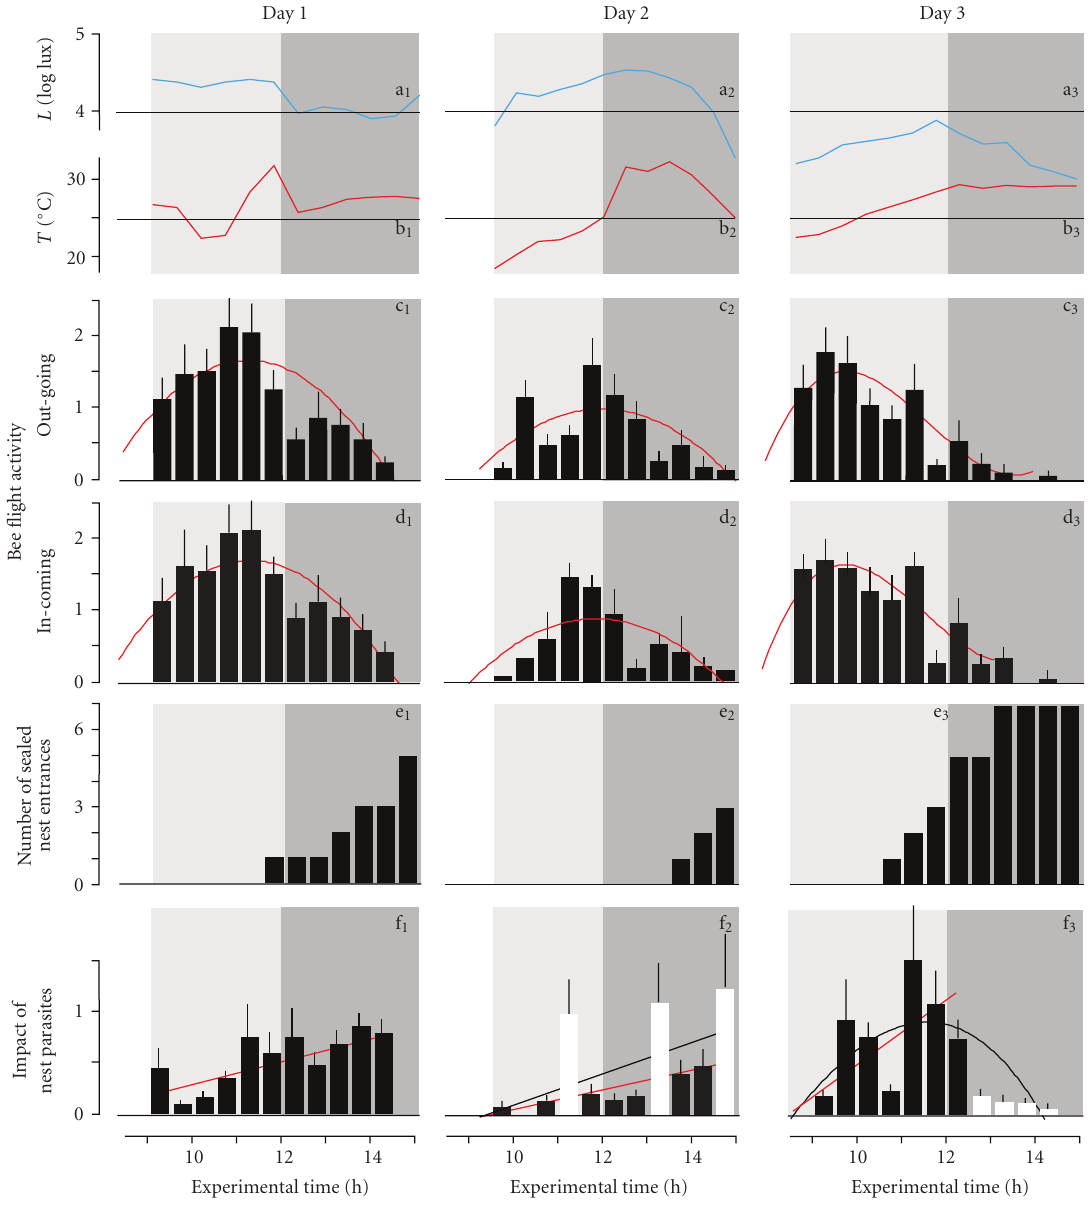
Figure 4: Activities observed at 28 nests (four batches) of Halictus scabiosae nests over three days (1–3). (a) Irradiance in lux and (b) ambient temperature in ◦ C measured in the shade. (c) Out-flying and (d) incoming activity pooled over all 28 nests; data were normalized per nest and 30 minutes of observation time; red curves show the regression functions, which allow to extrapolate the flight rates before the start of the observation sessions (which are coded by the grey background; am, bright grey; pm, dark grey); (e) sealing activity at the study site, given by the number of sealed nests in steps of 30 minutes; (f) the impact of nest parasites (for measurement, see Methods) on the experimental nests of H . scabiosae , given by the number of parasites per nest and 30 minutes of observation time. The regression curves (red) refer to all means coded in black columns which are used for further analysis (for equations of the regression functions see Tables 1 and 2 and text).